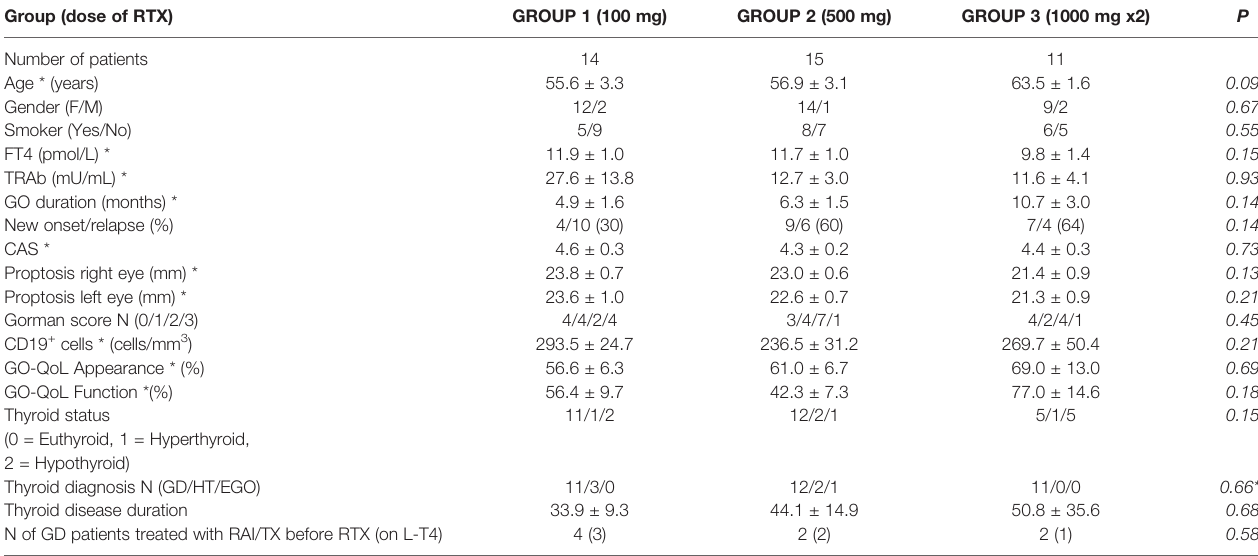
TABLE 1 | Baseline clinical characteristics of patients with moderate-to-severe GO treated with different doses of RTX. Group (dose of